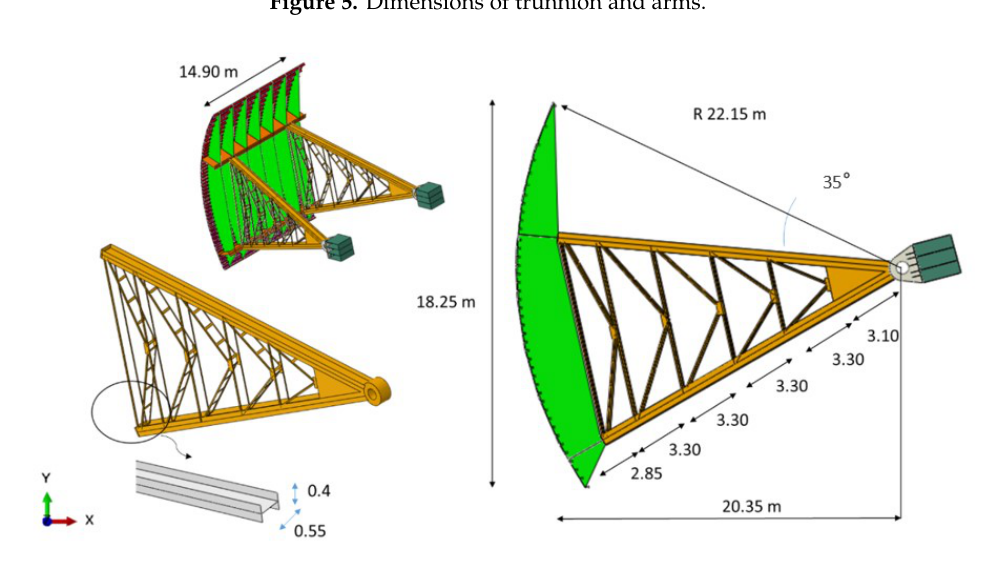
Figure 5. Dimensions of trunnion and arms.